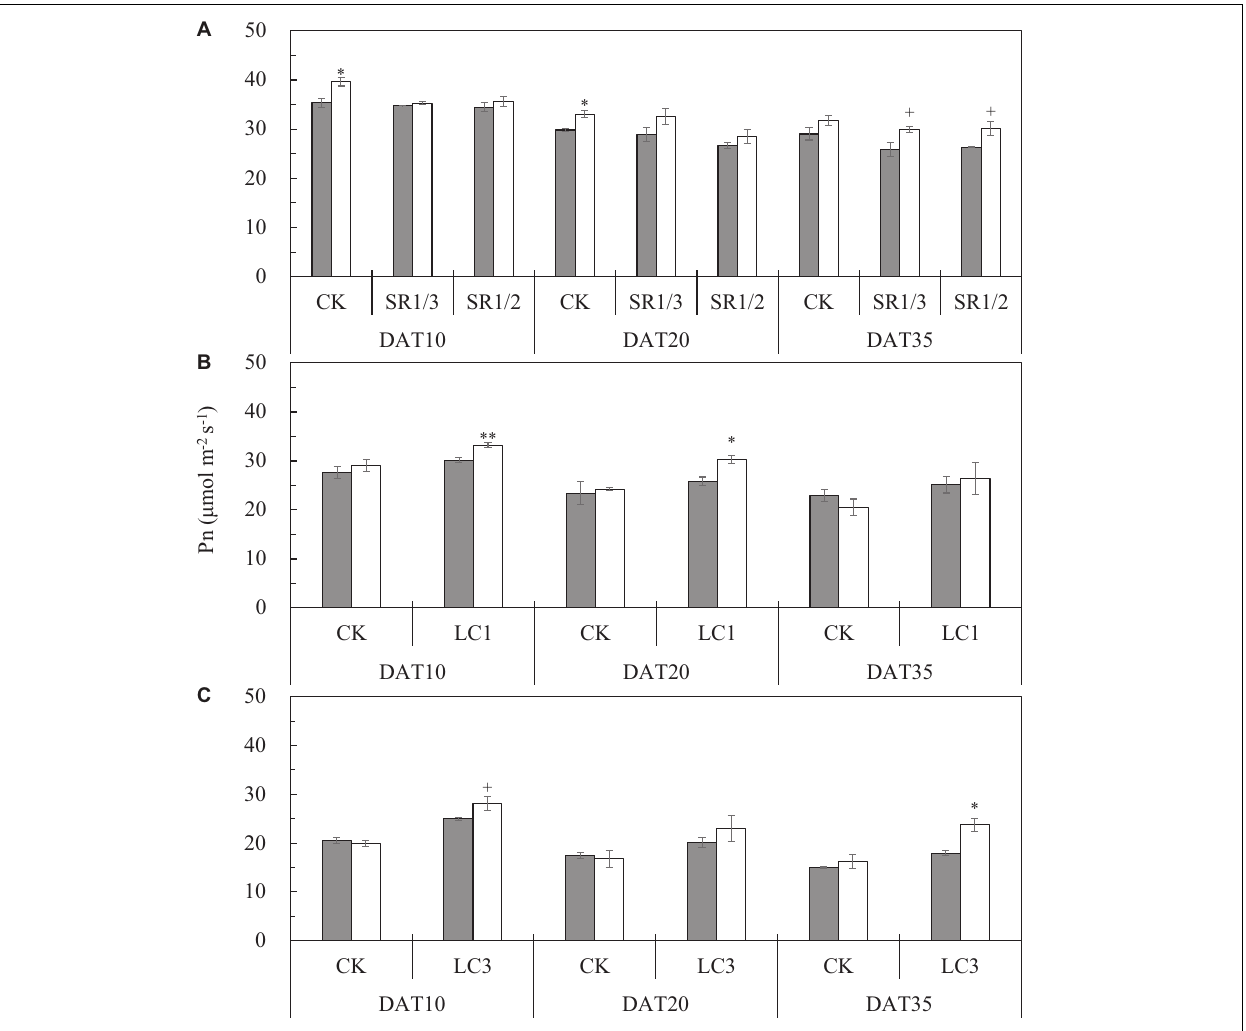
FIGURE 6 | The Pn of flag leaf [ (A) ; CK, SR1/3, and SR1/2], second leaf [ (B) ; CK and LC1], and fourth leaf [ (C) ; CK and LC3] of WYJ27 at different stages affected by elevated CO 2 and different source-sink treatments in 2017. Each bar in the figure represents the mean values across three plots for ambient CO 2 (aCO 2 , filled square) or elevated CO 2 (eCO 2 , aCO 2 + 200 ppm, unfilled square); vertical bars represent standard error ( n = 3). SR, spikelet removing treatments; CK, no leaf cutting or spikelet removal; LC1, cutting off the flag leaf; LC3, cutting off top three leaves; SR1/3, removing one branch in every three branches of a panicle; SR1/2, removing one branch in every two branches of a panicle. DAT, day after source-sink treatment. ** P < 0.01, * P < 0.05, + P < 0.1.